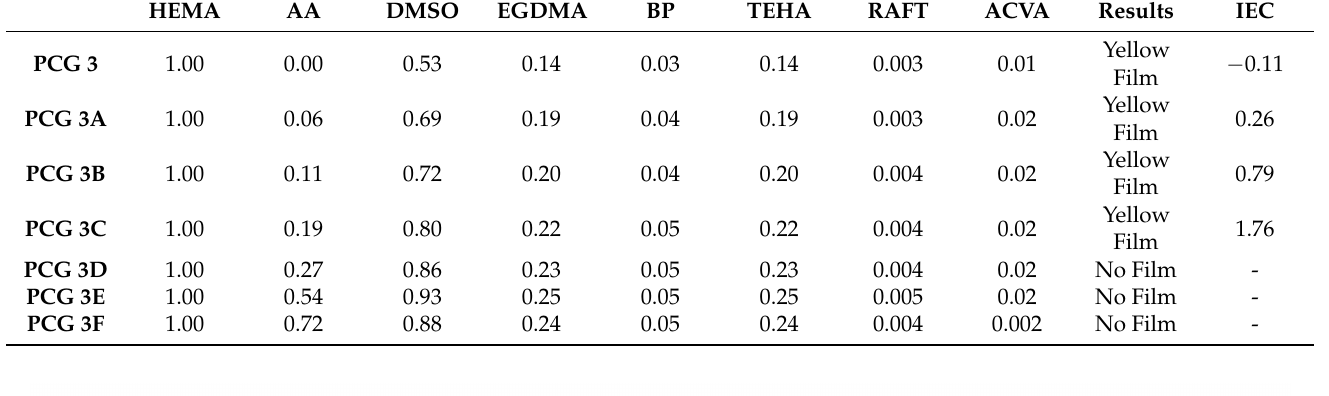
Table 2. Molar ratios of EGDMA crosslinked hydrogel film mixtures.